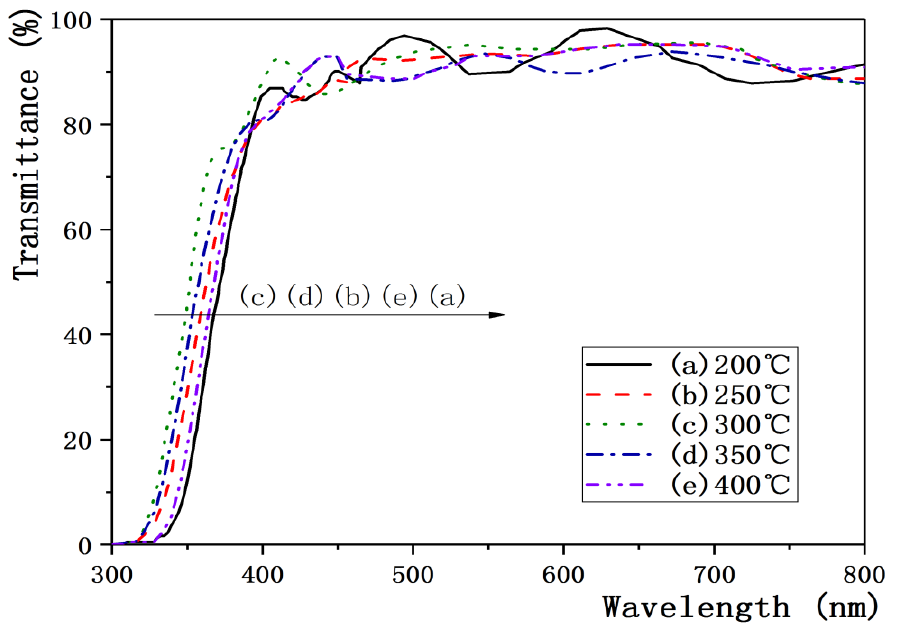
Figure 6. Transmission spectra of ZnO:Ga films prepared at different substrate temperature [75]. Table 3. The performances of ZnO:Ga films produced at different substrate temperature [75]. Substrate Temperature ( ◦